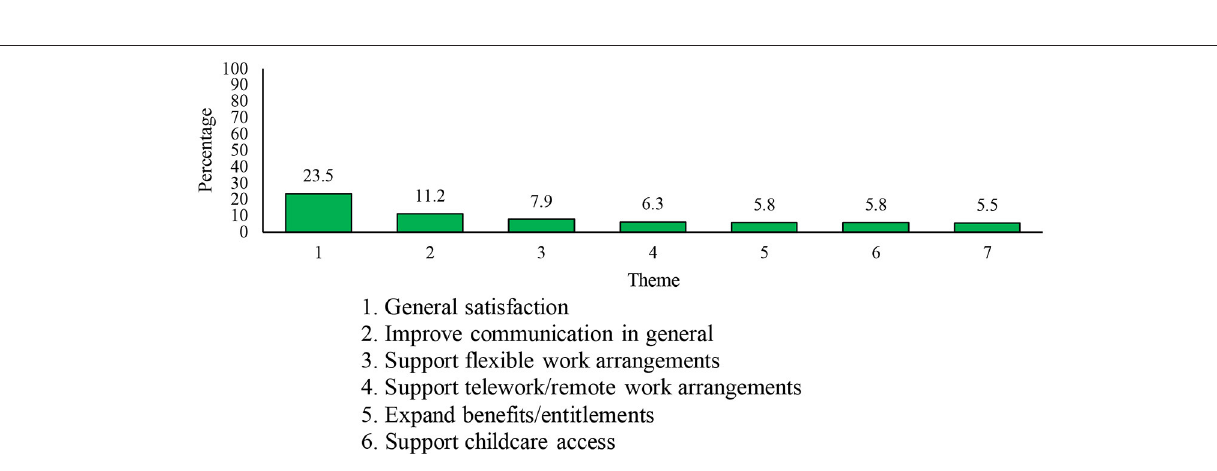
FIGURE 9 | Seven most frequently mentioned themes relating to how the DND/CAF can better support personal and family needs during the COVID-19